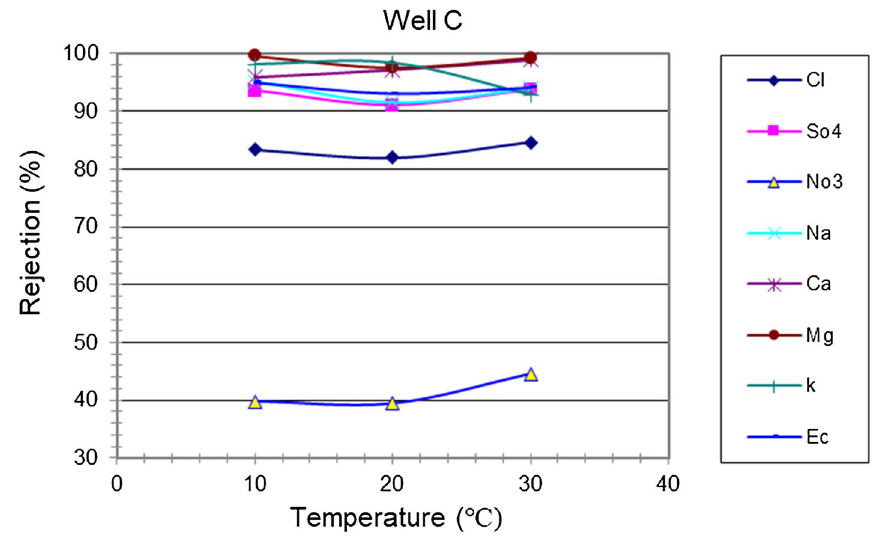
Fig. 12 Rejection rate of ions versus temperature (pressure: 8